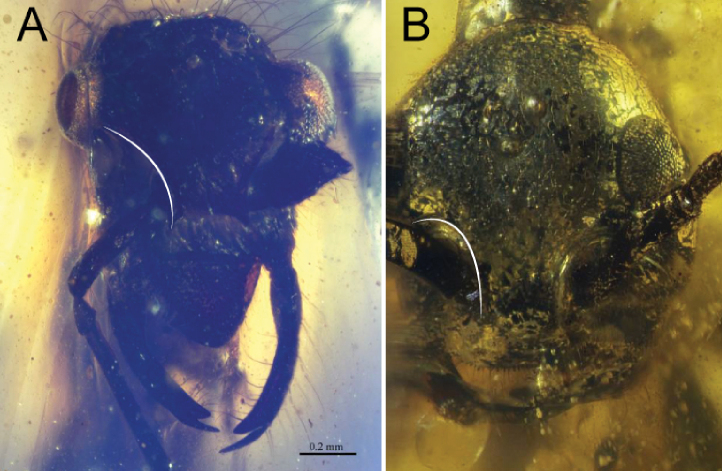
Cranial gestalts of †Sphecomyrminaesensu strictoA †Myanmyrma
maraudera (Barden & Grimaldi, 2016) comb. nov., holotype worker, full-face (JZCBU1846, AntWeb: Phillip Barden) B †Gerontoformica species, worker, full-face (ANTWEB1038348).